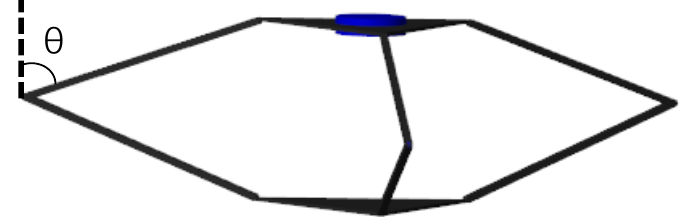
Figure 5. Schematic of the simulation robot in compressed state.